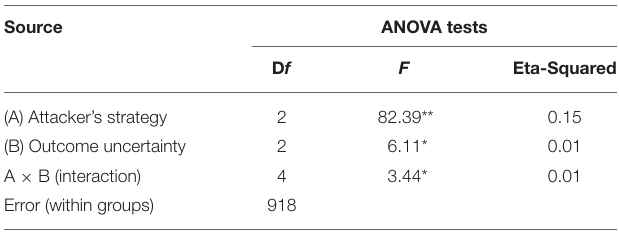
TABLE 1 | Factorial analysis of variance for final payoffs.